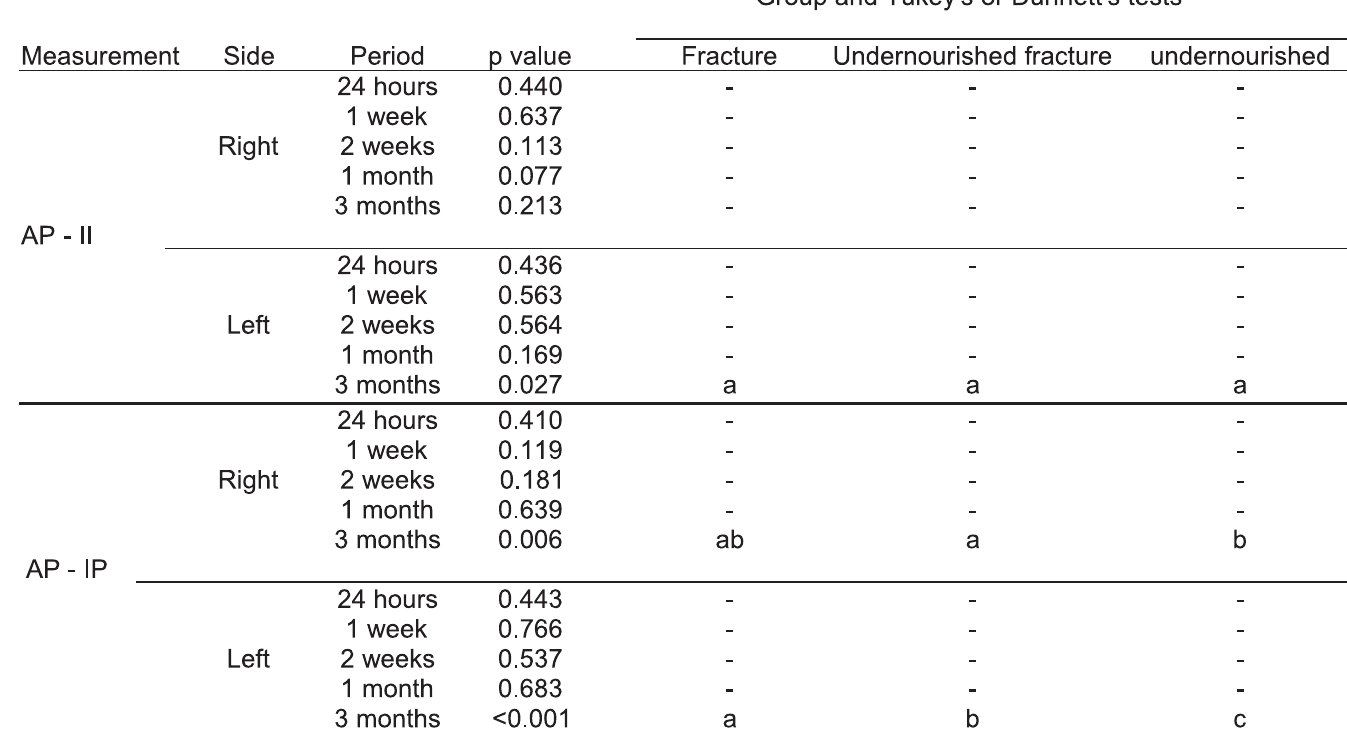
Distinct letters indicate statistically significant difference